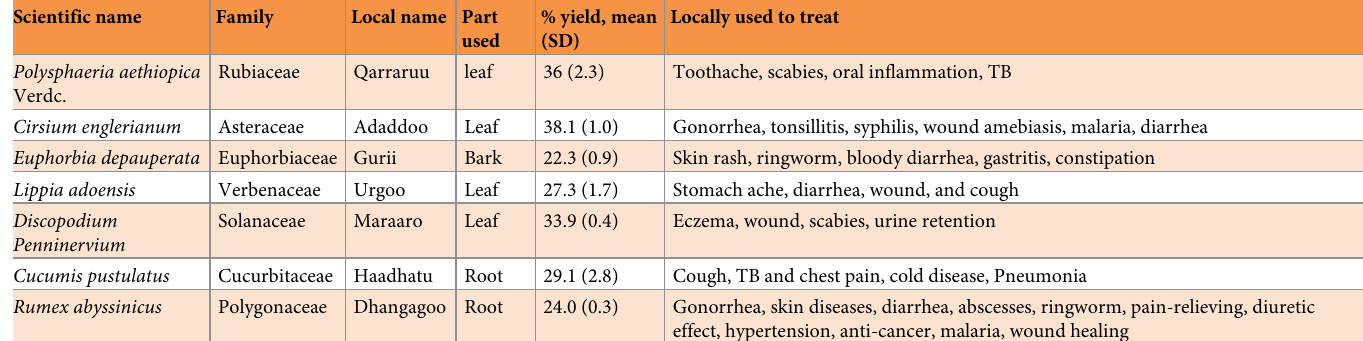
Table 3. Ethno-botanical data and percentage yields of medicinal plants tested on selected human pathogens. Scientific name